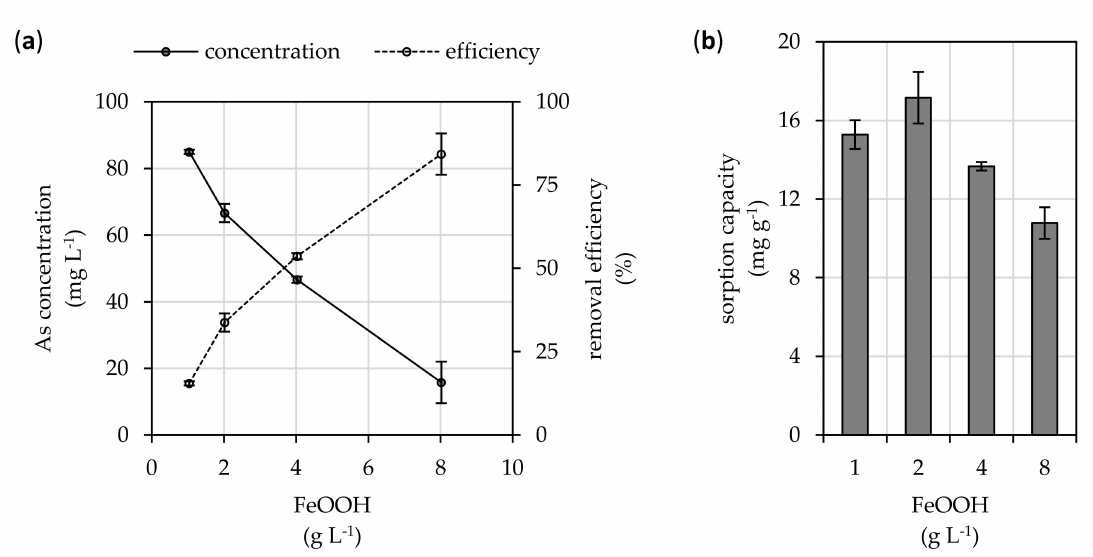
Figure 1. ( a ) Arsenic removal e ffi ciency and its equilibrium concentration in the solution after its sorption onto FeOOH. ( b ) Concentration of arsenic in the FeOOH adsorbent after sorption at equilibrium (initial As concentration was 100 mg L − 1 ; contact time 24 h; temperature of 25 ◦ C; agitation rate 130 rpm). Results represent the mean values of four independent experiments, and the error bars show the standard